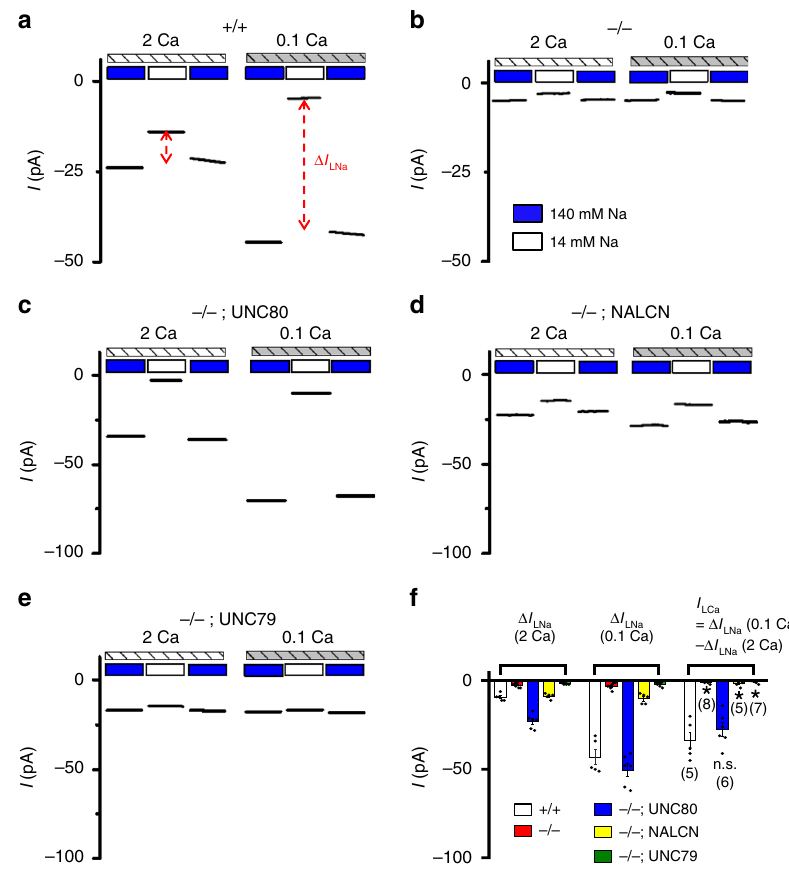
Fig. 2 UNC80 is required for the TTX-resistant Na + leak current and its regulation by extracellular Ca 2 + . a , b Representative TTX-resistant Na + leak current recorded in hippocampal neurons cultured from WT ( + / + ) ( a ) and UNC80 KO ( − / − ) ( b ) pups. Each trace represents 1 s of currents recorded at − 70 mV in bath solutions with varying [Na + ] (140 or 14 mM) and [Ca 2 + ] (2 or 0.1 mM). The Na + -leak current ( Δ I LNa ) is calculated as the difference of current sizes between those recorded under 140 mM [Na + ] and 14 mM [Na + ], as indicated by dashed lines. c – e Similar to a , but recorded from UNC80 KO neurons transfected with UNC80 ( c ), NALCN ( d ), or UNC79 ( e ) cDNA. f Averaged sizes of currents in a – e . I LCa is the current activated by lowering [Ca 2 + ] from 2 to 0.1 mM, as de fi ned as the size difference of Δ I LNa under the two [Ca 2 + ] conditions). Data are presented as mean values ± SEM. Numbers of neurons are in parentheses. In ( f ), two sample t test of each group against the “ + / + ” group ( n = 5) was performed: “ − / − ” ( n = 8, p ≤ 0.001), “ − / − ; UNC80 ” ( n = 6, p = 0.326), “ − / − ; NALCN ” ( n = 5, p ≤ 0.001), “ − / − ; UNC79 ” ( n = 7, p ≤ 0.001). Asterisk “ * ” indicates p < 0.05. Source data are provided as a Source Data fi